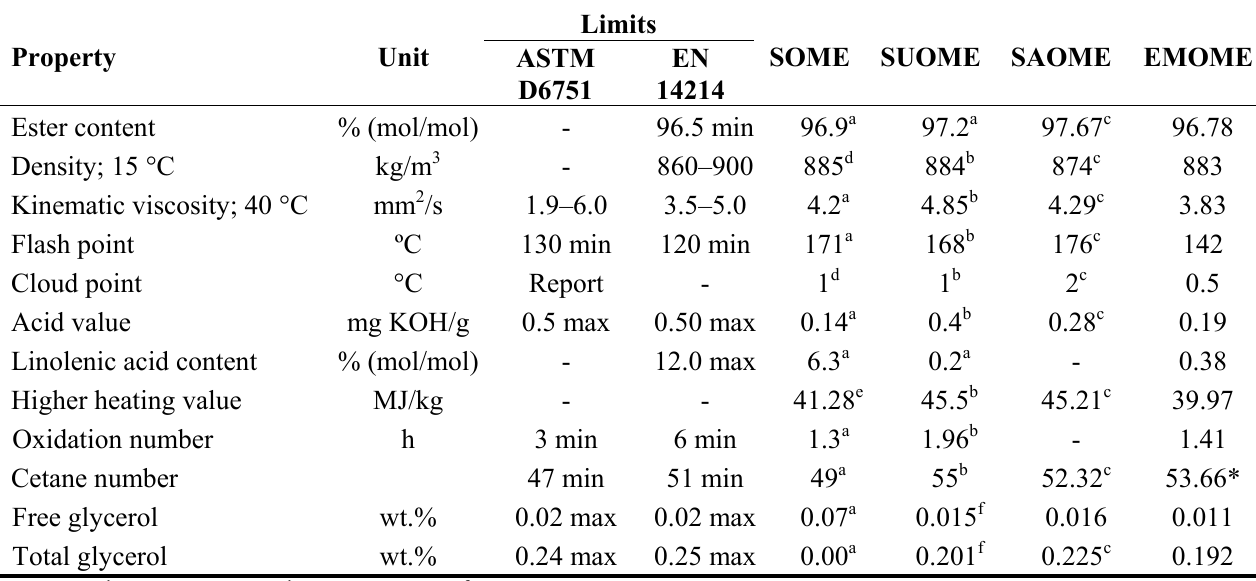
Table 3. Fuel properties of egusi melon oil biodiesel and other biodiesel